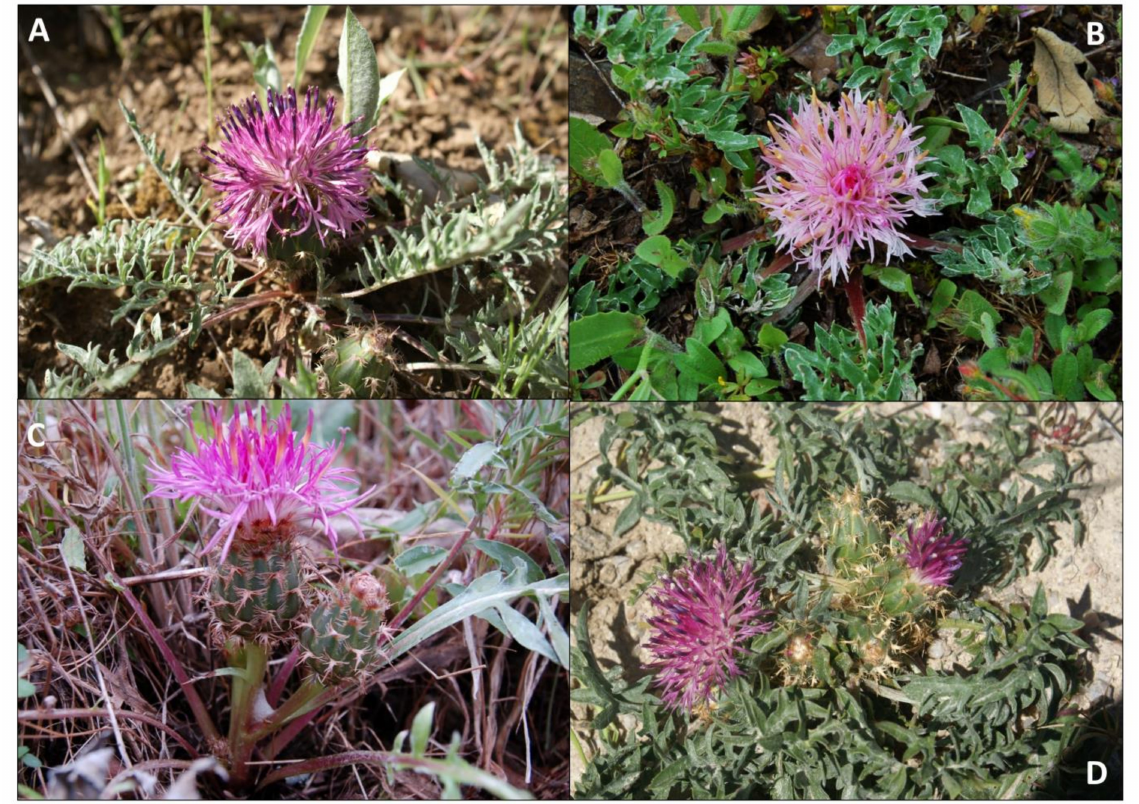
Figure 7. ( A ) Centaurea tentudaica with dark pink florets and acaulescent habit and purple anther tubes; ( B ) Centaurea tentudaica with pale pink florets and orange anther tubes; ( C ) Centaurea tentudaica with leaves similar to C. cephalariifolia and caulescent habit; ( D ) Centaurea amblensis . Photos: ( A – C ) Alfonso Susanna; ( D ) Francisco M á